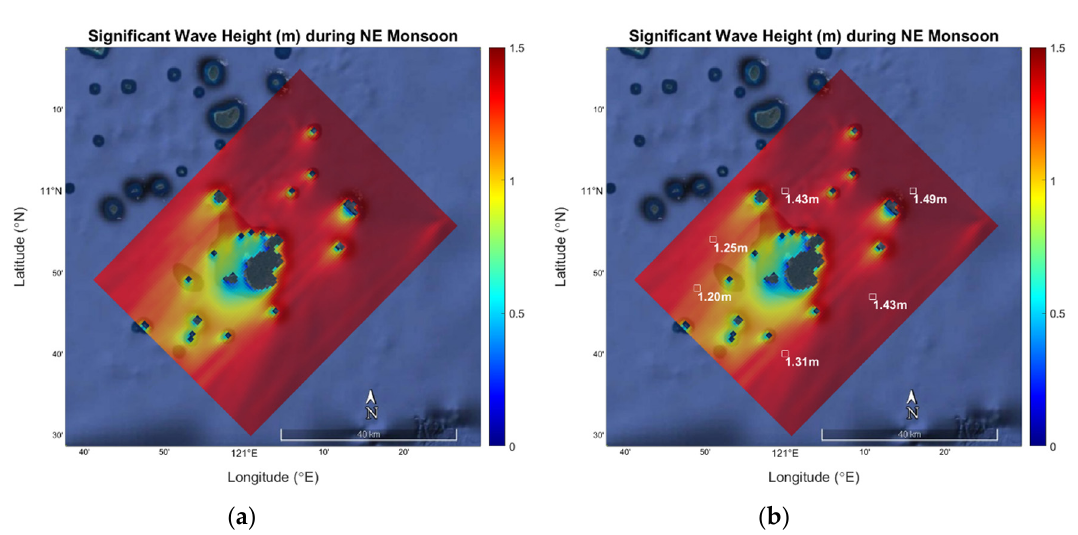
Figure 14. Location of the six (6) points of interest within the model domain (stations A–F).